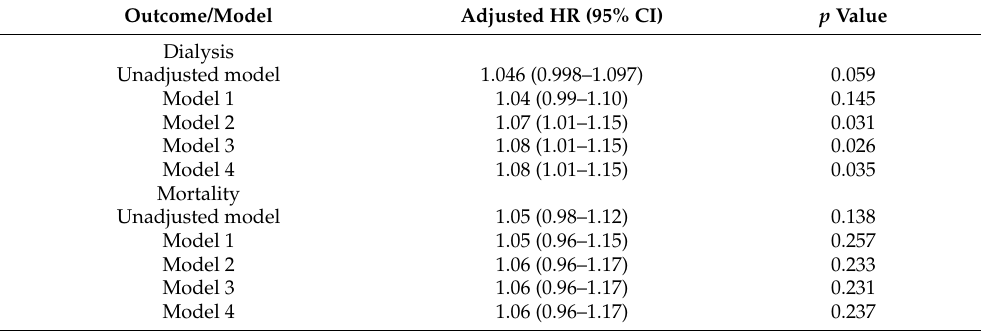
Table 2. Association of serum DKK1 level (per 100 pg/mL increase) with the risk of outcomes (n = 50).